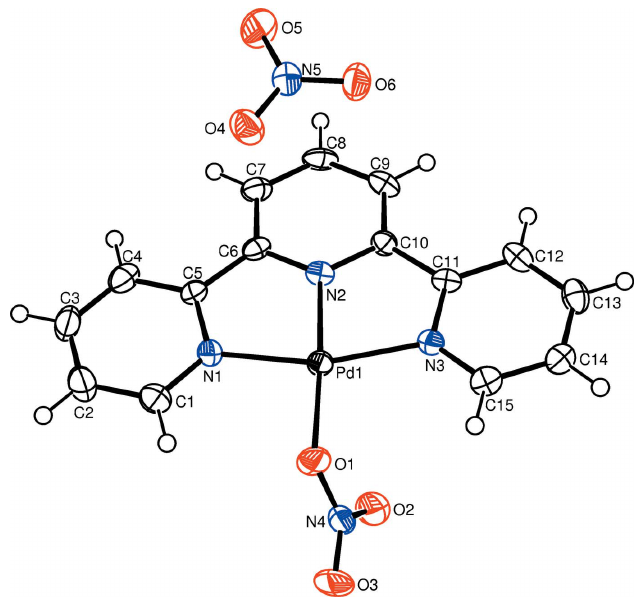
Figure 1 The molecular structure of the title complex showing the atom labelling and displacement ellipsoids drawn at the 50% probability level for non-H atoms.